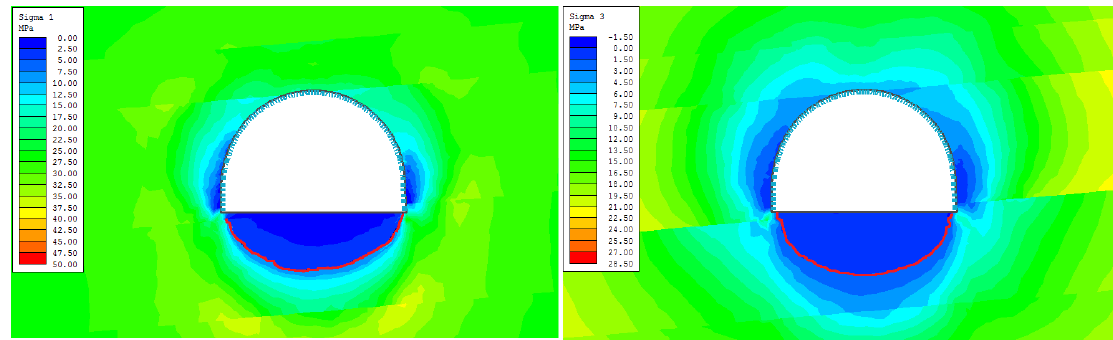
Figure 25. Extent of the failure zone beneath the waterlogged floor of roadway D-2 — stage 5.